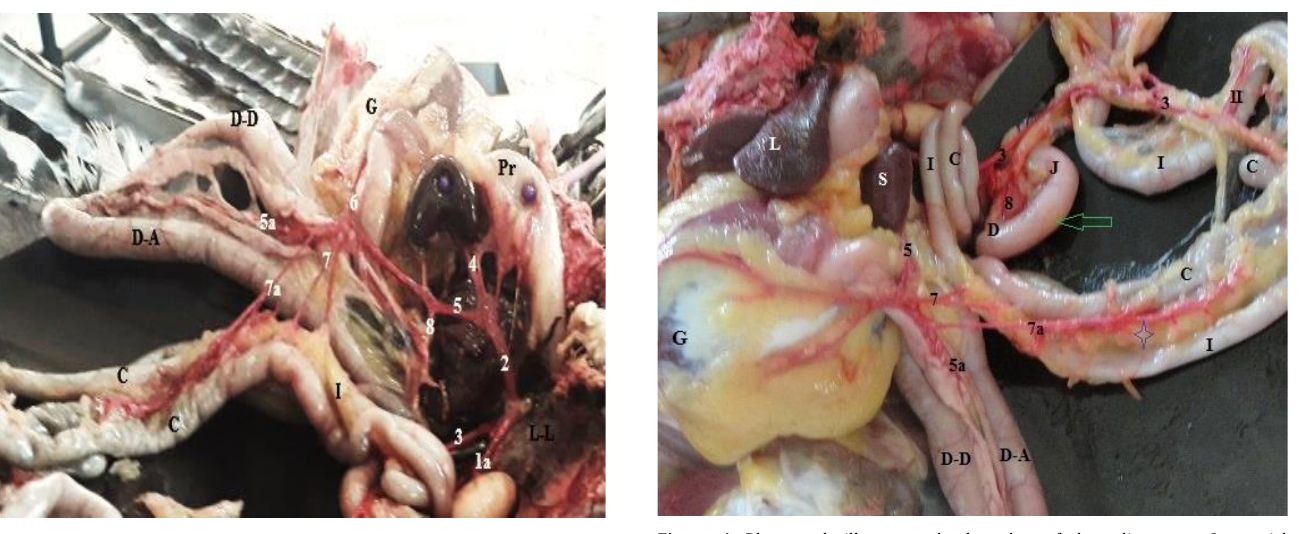
Figure 3. Photograph illustrates,1a :green arrow descending aorta, 2:celiac a.,3: Cranial mesenteric a.:4:Left ramus a.,5:right ramus a.,5a: Pancreaticoduodenal a.,6: gastroduodenal artery 7,7a :ileocecal a(ilial a., cecal a.).8: jejunala.Pr: Proventriculus, A- D& D-D: ascending and descending duodenum , C: ceca, G-Gizzard,L-L :left lung